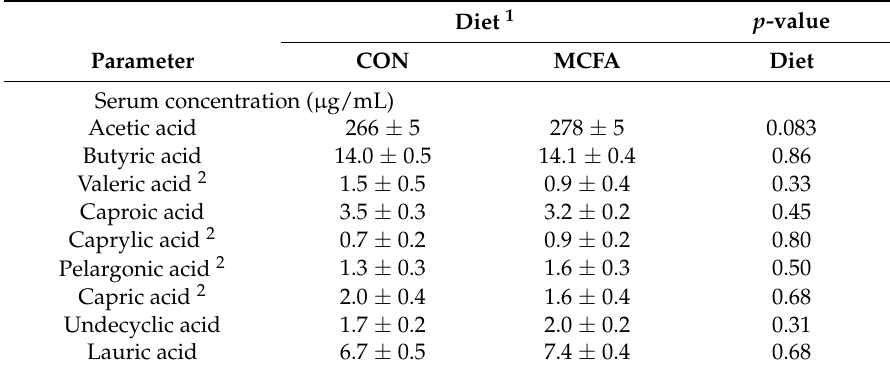
Table 7. Piglet serum fatty acid concentrations on day 3 of lactation after dams fed either a commercial control diet (CON), or a diet supplemented with a medium-chain fatty acid (MCFA) product in late gestation and